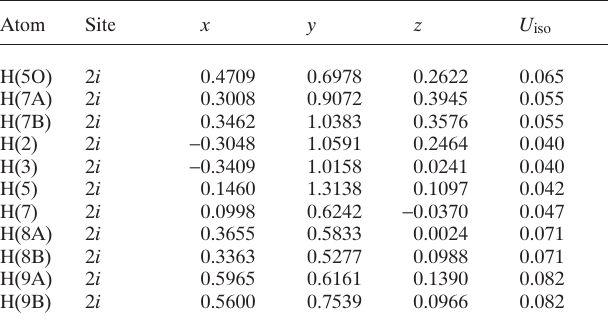
Table 2. Atomic coordinates and displacement parameters (in Å 2 )